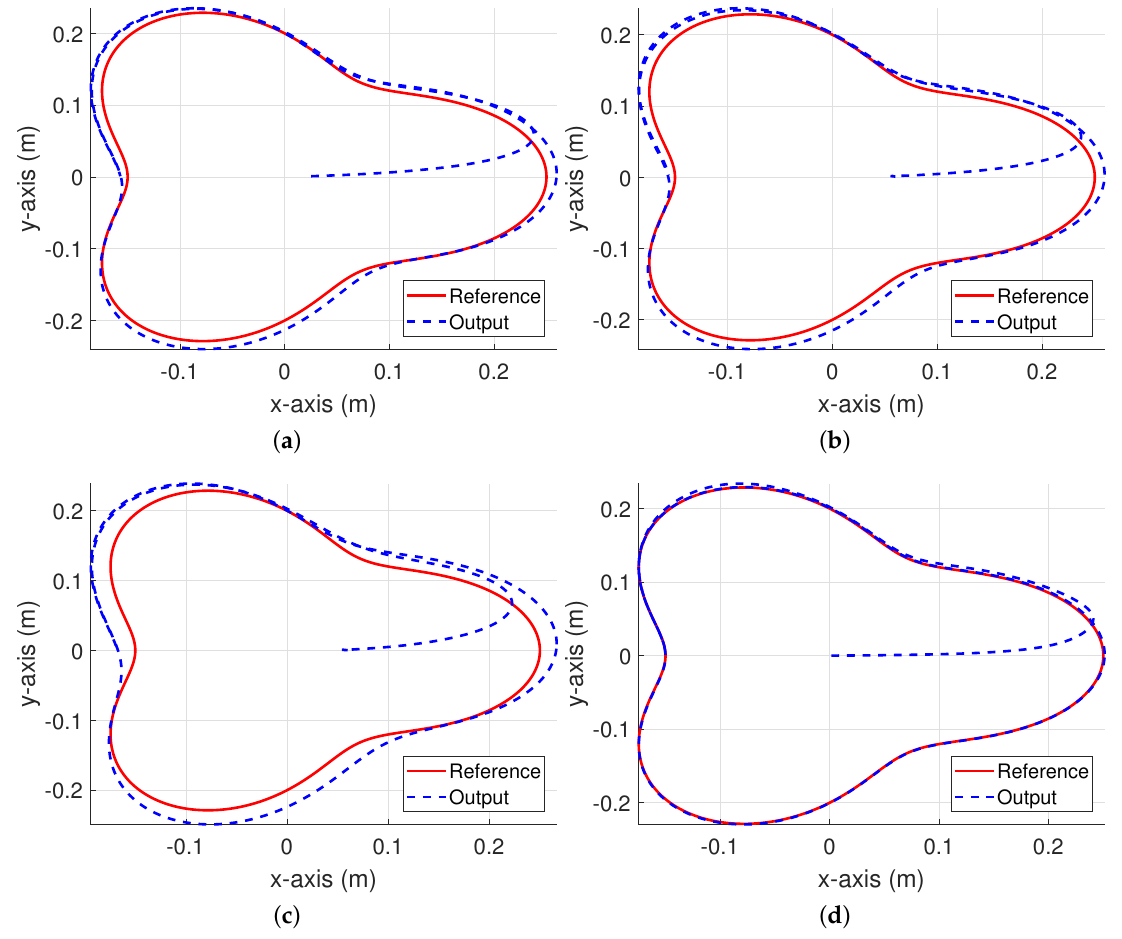
Figure 12. Trajectory following results for the rose curve trajectory. ( a ) Trajectory following for PID) . ( b ) Trajectory following for BP-PIDNN. ( c ) Trajectory following for HR-PIDNN. ( d ) Trajectory following for